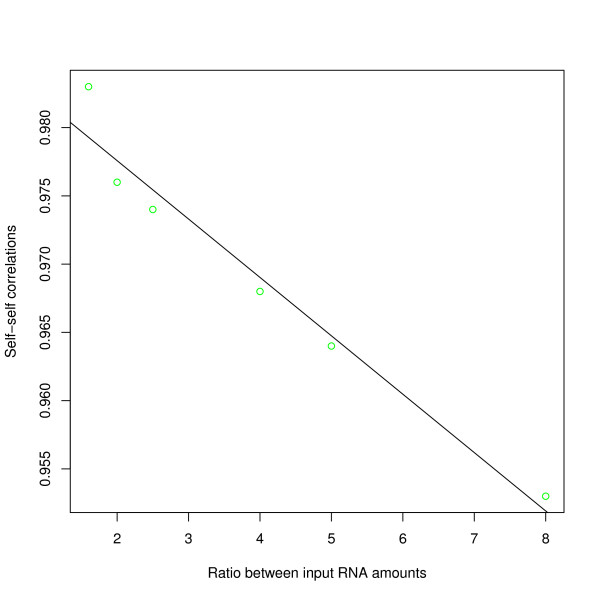
Linear regression analysis revealed that self-self correlations in probe signal intensities between arrays hybridized to different amounts of RNA from an NSCLC T2 tumor (preserved in RNAlater) decreased when deviations in RNA amounts between pairs increased, considering all pair wise combinations (bDevRNAinput = 0.0002 ± 0.00002, t = -11.7, p < 0.001, R2 = 0.96).